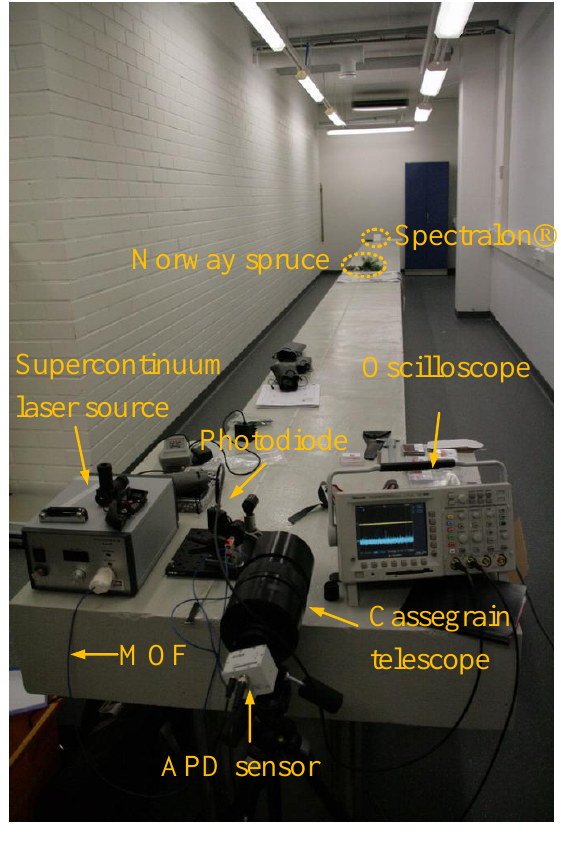
Figure 2. Hyperspectral LiDAR demonstration instrument used in the laboratory